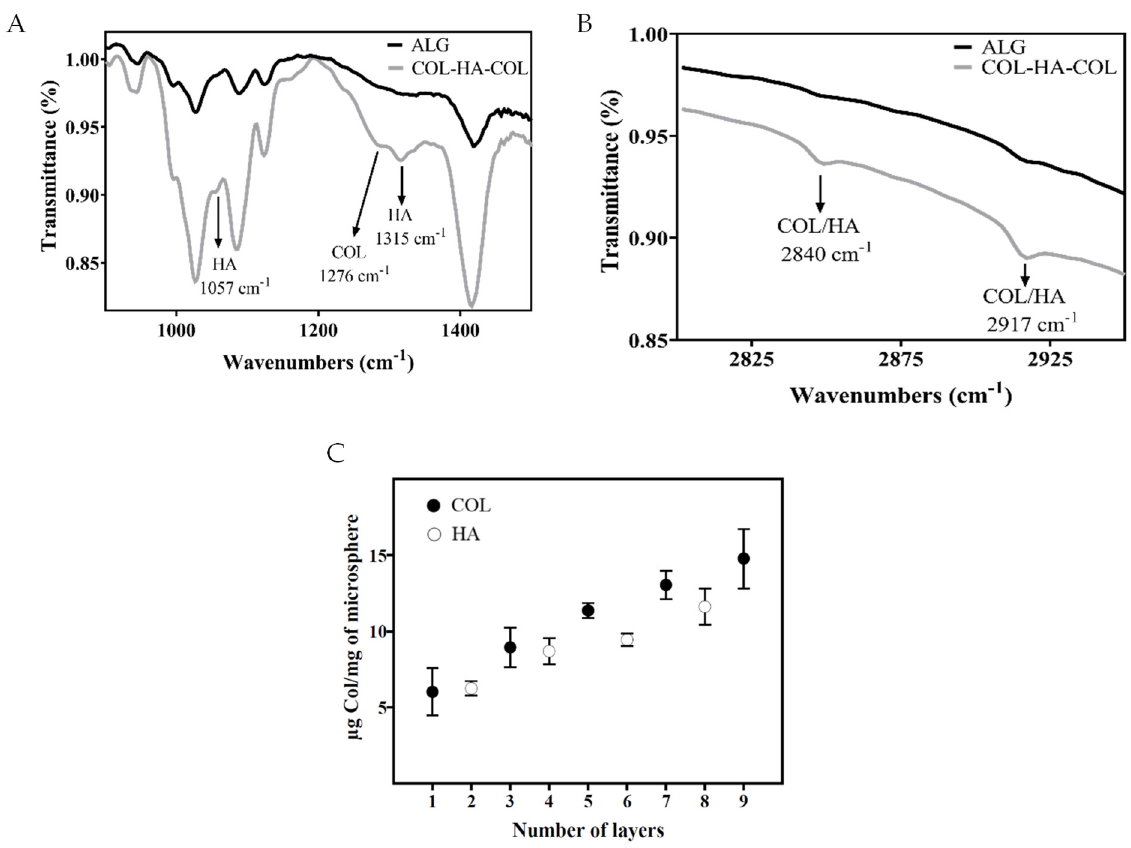
Figure 2. ( A , B ) FTIR spectrum of a flat uncoated alginate hydrogel (ALG) and a three-layer layer-by-layer coating collagen- hyaluronic acid-collagen (COL-HA-COL); ( C ) Collagen content in the layer-by-layer coating by adding layers of collagen and hyaluronic acid successively, as determined by Micro-BCA. ALG: alginate hydrogel; COL: collagen; HA: hyaluronic acid.